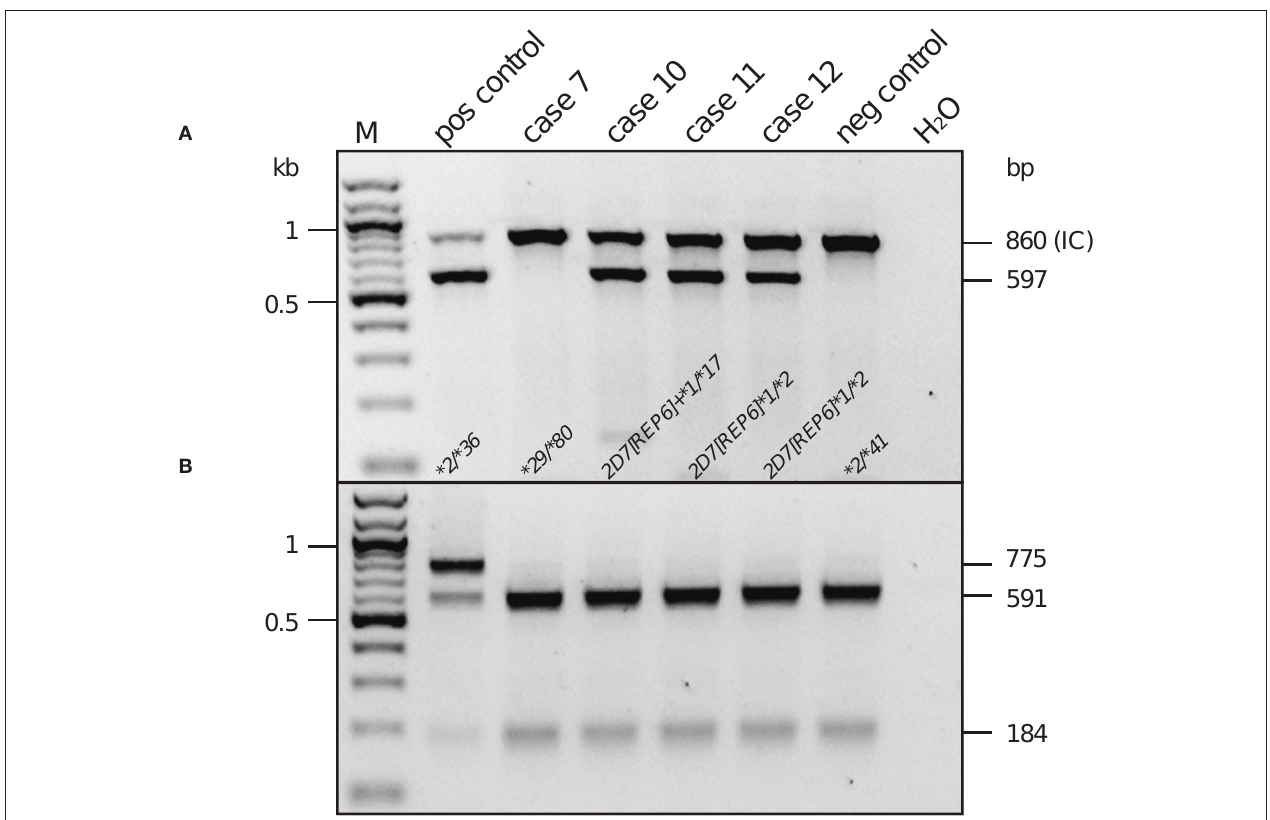
Figure 5 | genotype analysis for CYP2D7 exon 9 conversion and CYP2D7[REP6] . M, 100-bp ladder. Cases, positive, and negative control DNAs and their respective genotypes are as indicated. Selected marker bands are given in kilobyte to the left; PCR product and restriction fragment lengths are shown to the right in base pair. The top panel (A) shows a duplex assay performed on genomic DNA that detects the CYP2D6 exon 9 conversion present in e.g., CYP2D6 * 36 and alleles carrying a CYP2D7[REP6] . The forward primer is specific for CYP2D7 exon 9 and the reverse primer for CYP2D6 binding to the REP6